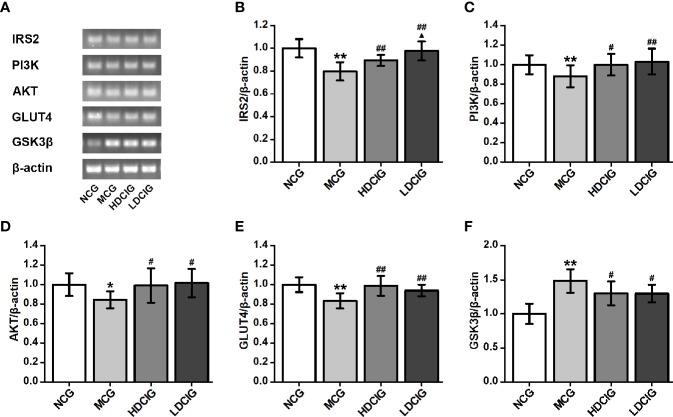
Effects of D-chiro-inositol (DCI) on the expression level of IRS2/PI3K/Akt/GLUT4/GSK3β signal pathway-related mRNA in liver tissues of db/db mice. (A) Nucleic acid results of insulin receptor substrate 2 (IRS2), phosphatidylinositol 3–kinase (PI3K), protein kinase B (AKT), glucose transporters 4 (GLUT4), glycogen synthase kinase 3β (GSK3β), and β-actin are listed. Our samples were derived from the same experiment and that gels were processed in parallel. (B) The result of IRS2. (C) The result of PI3K. (D) The result of AKT. (E) The result of GLUT4. (F) The result of GSK3β. Grayscale value was determined using Image J based on immunoblot bands (n=3). The results obtained for the different groups were normalized to those reported in normal control group (NCG). All values are expressed as means ± SD. *P < 0.05, **P < 0.01 vs. (NCG) mice; #P < 0.05, ##P < 0.01 vs. model control group (MCG) mice; ▲P < 0.05 vs. high-dose D-chiro-inositol group (HDCIG) mice.